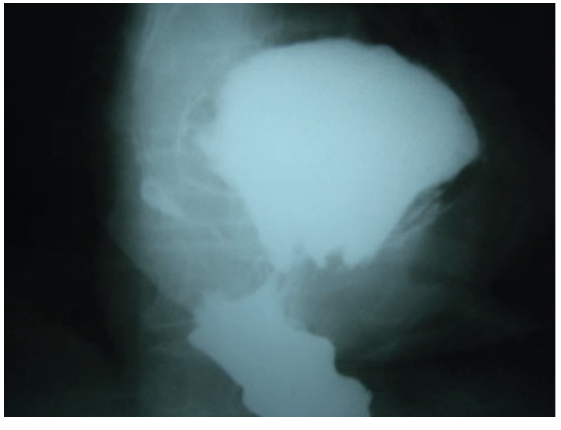
Figure 1. Esophagus-stomach-duodenum barium study revealed a gastric volvulus with paraesophageal hernia.